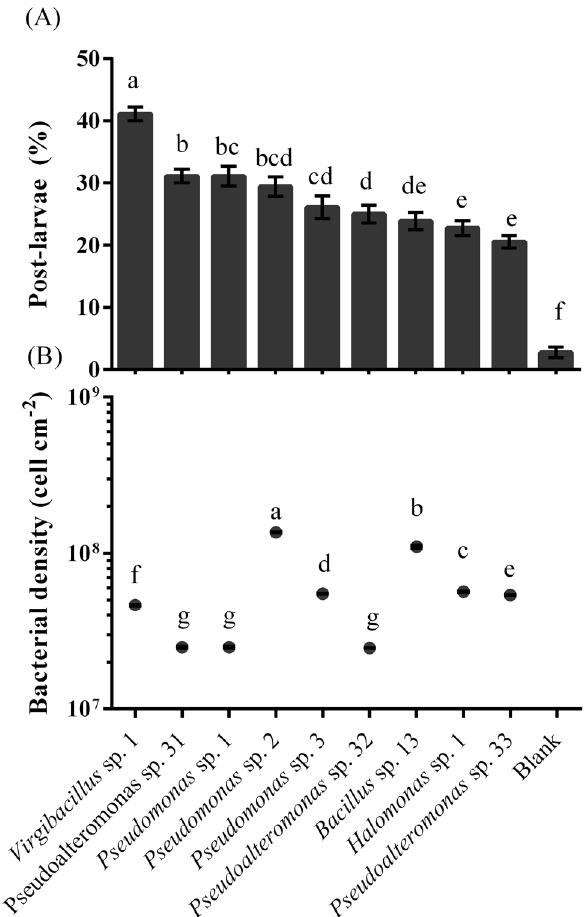
Figure 1. M. coruscus post-larval rates ( A ) in deep-sea bacterial BFs in relation to BF ʼ s cell density ( B ). Small letter suggests significant variance ( p < 0.05). Means ± SE (n = 9).